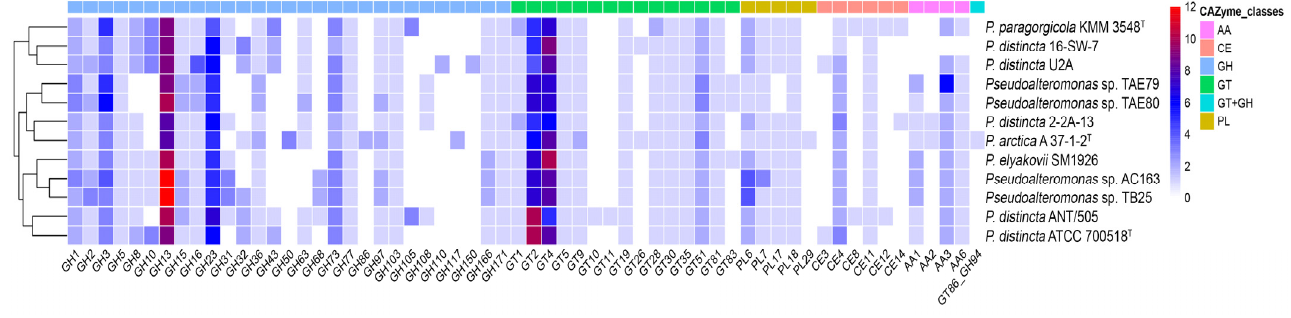
Figure 8. The distribution of carbohydrate-active enzymes (CAZymes) in the genomes of P. distincta and P. arctica A 37-1-2 T . The heat map shows the number of genes assigned to individual CAZyme families. Rows are clustered using Euclidean distances. Parc A 37-1-2 T , P. arctica A 37-1-2 T ; Pdis 2-2A-13, P. distincta 2-2A-13; Ppar KMM 3548 T , P. paragorgicola KMM 3548 T ; Paga DSM 14585 T , P. agarivorans DSM 14585 T ; Ptel DSM 16098, “ P. telluritireducens ” DSM 16098; Pnig NBRC 103036 T , P. nigrifaciens NBRC 103036 T ; Ptra KMM 520 T , P. translucida KMM 520 T ; Pdis ANT/505, P. distincta ANT/505; Psp TAE79, Pseudoalteromonas sp. TAE79; Psp TAE80, Pseudoalteromonas sp. TAE80.